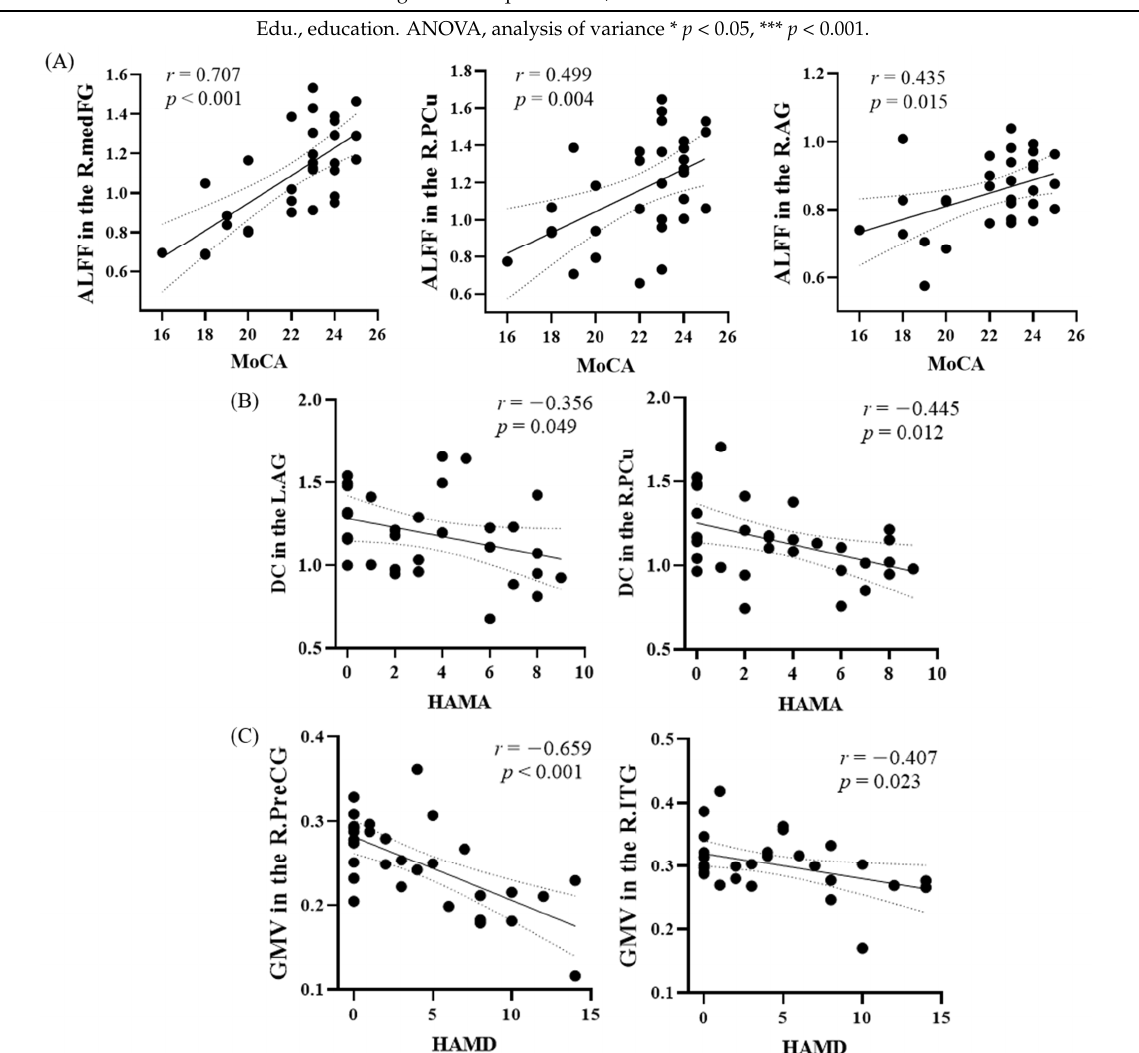
Figure 3. Linear correlation between brain functional and structural changes and clinical characteristics in VaMCI. ( A ) Positive correlation between MoCA and ALFF in the R.medFG, R.PCu, and R.AG. ( B ) Negative correlation between HAMA and DC in the R.PCu and L.AG. ( C ) Negative correlation between HAMD and GMV in the R.PreCG and R.ITG. PCu, precuneus; AG, angular gyrus; medFG, medial frontal gyrus; PreCG, precentral gyrus; ITG, inferior temporal gyrus; L., left; R., right. Table 4. Linear regression between MoCA and ALFF, HAMA and DC, and HAMD and GMV.